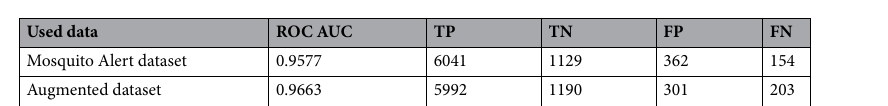
Table 2. Yearly cross-validation results with using the Mosquito Alert dataset alone and its IP102 augmented version. The additional non-tiger mosquito insect images were used only to balance out the train dataset, they were not used in the validation dataset. The area under the receiver operating characteristic curve (ROC AUC), true positive (TP), true negative (TN), false positive (FP), false negative (FN) is shown.